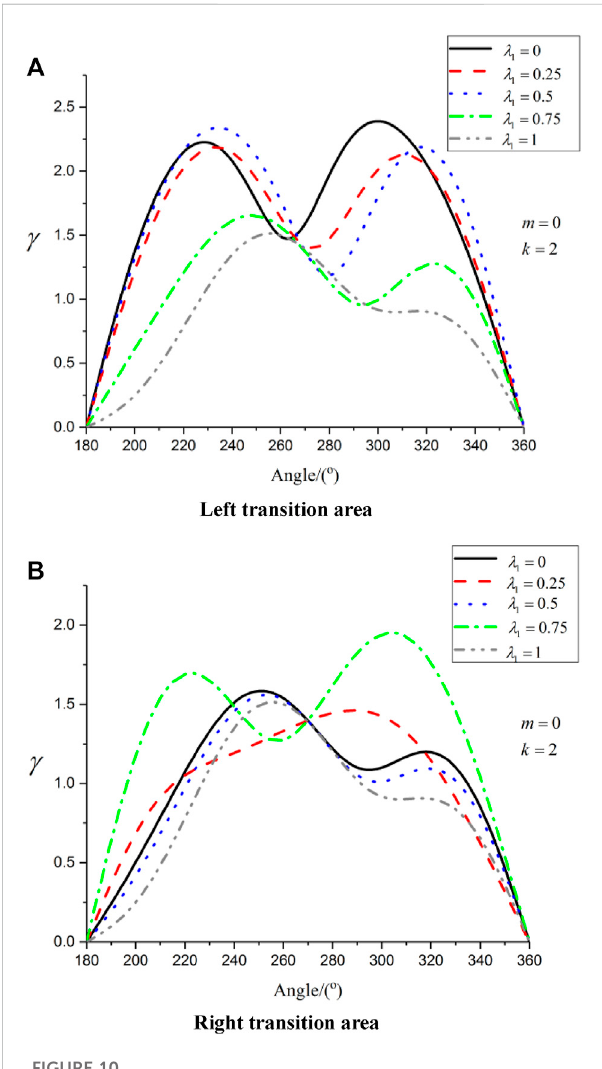
FIGURE 10 Distribution of hoop dynamic stress concentration factor with k (cid:2) 2 at semicircular depressions. (A,B) represent the results of these two subsets: Left transition area and Right transition